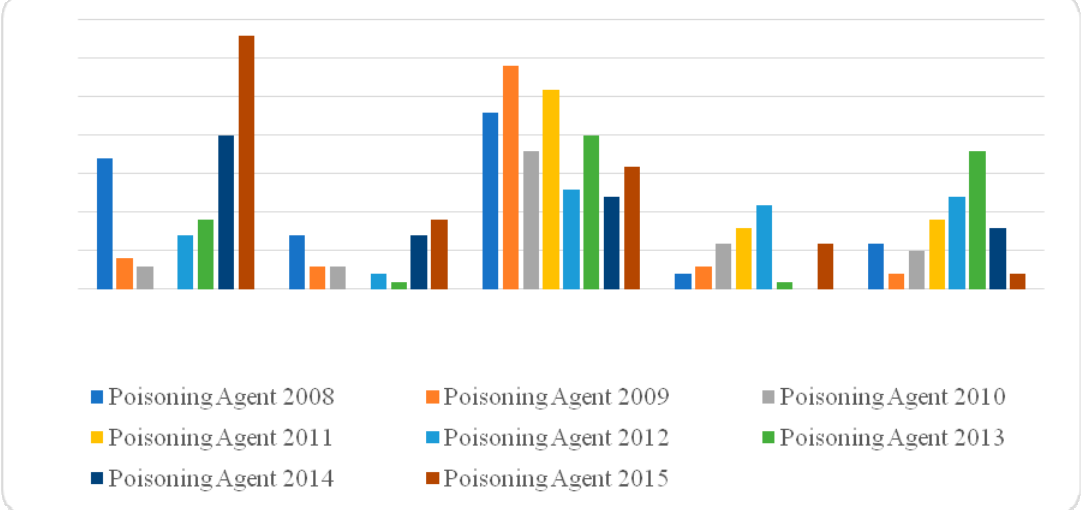
Figure 2. Frequency of poisonings and the type of poison ingested according to period of poisoning.